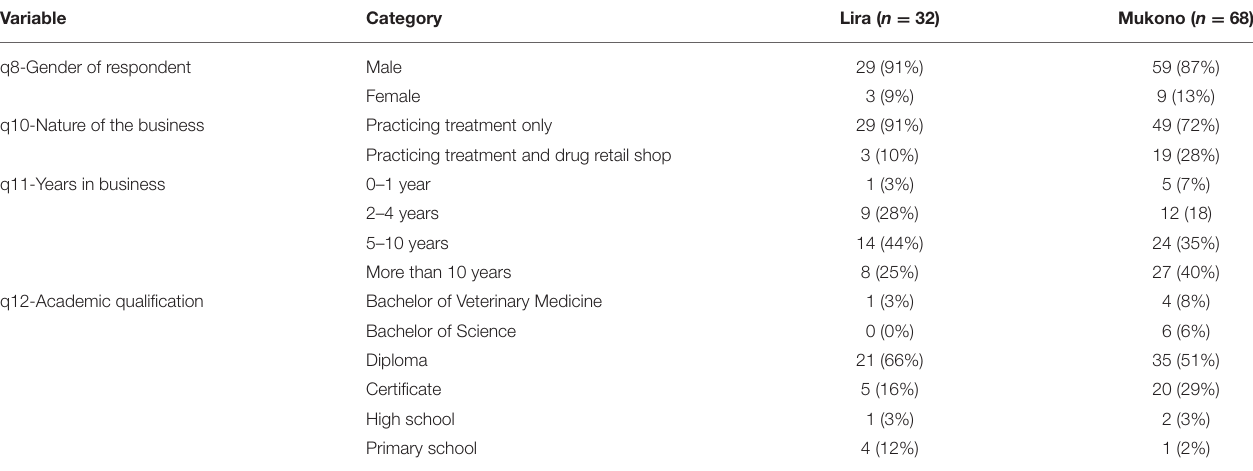
TABLE 4 | Demographic characteristics of veterinary practitioners.